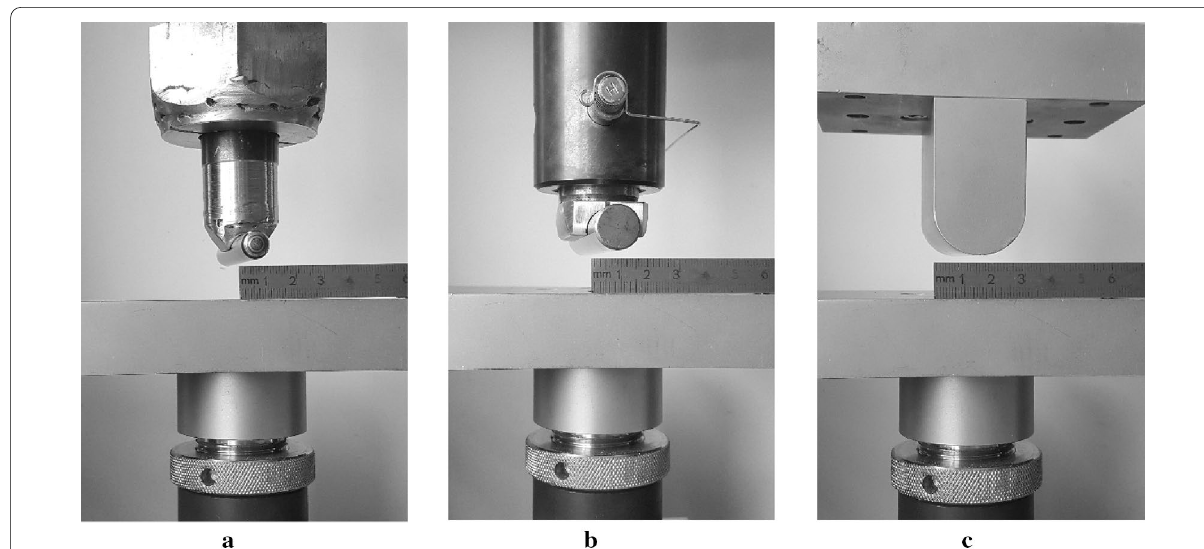
Fig. 4 Cylinder indenters with diameters, respectively: a 10 mm, b 15 mm, c 30